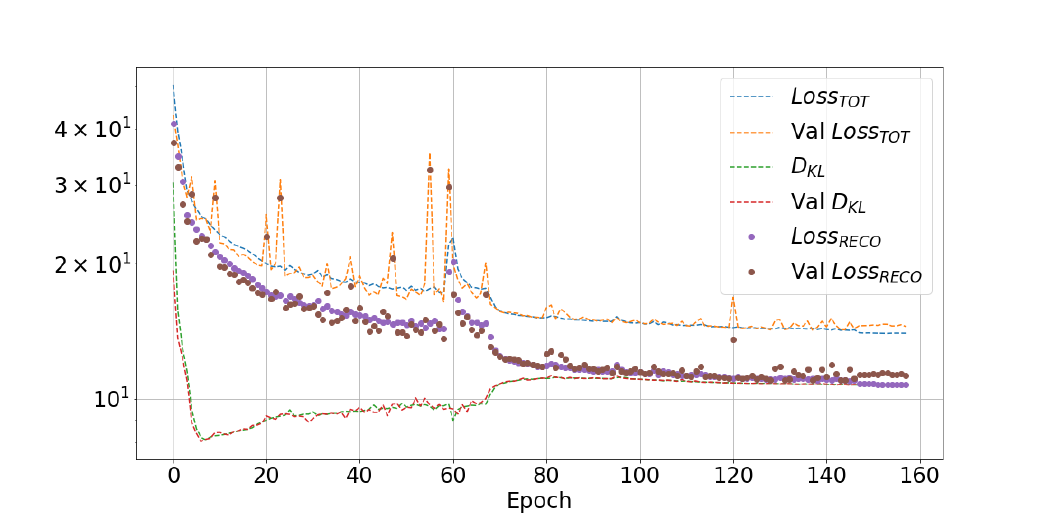
Figure 4 . Training history for VAE. Total loss, reconstruction negative-log-likelihood (Loss reoc ) and KL divergence ( D KL ) are shown separately for training and validation set though all the training